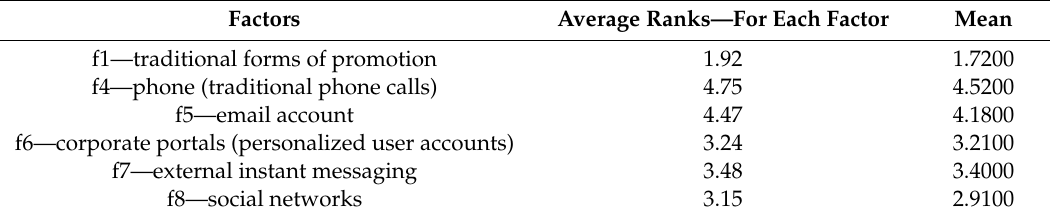
Table 24. Average ranks—for each factor of CCCI.